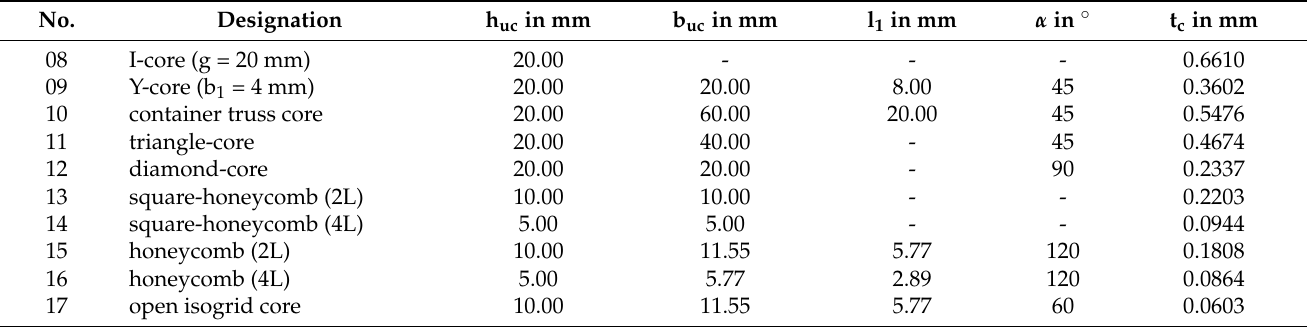
Table 2. Topology and parameters: one–side-open non-auxetic prismatic cell cores. See Figures 4 and 5.